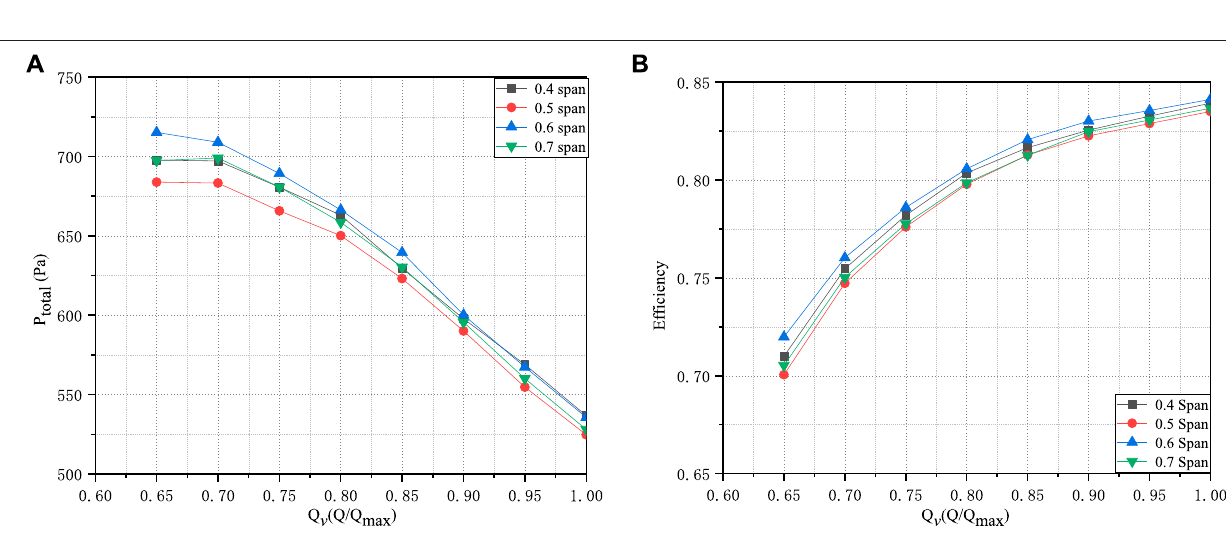
Frontiers in Energy Research |